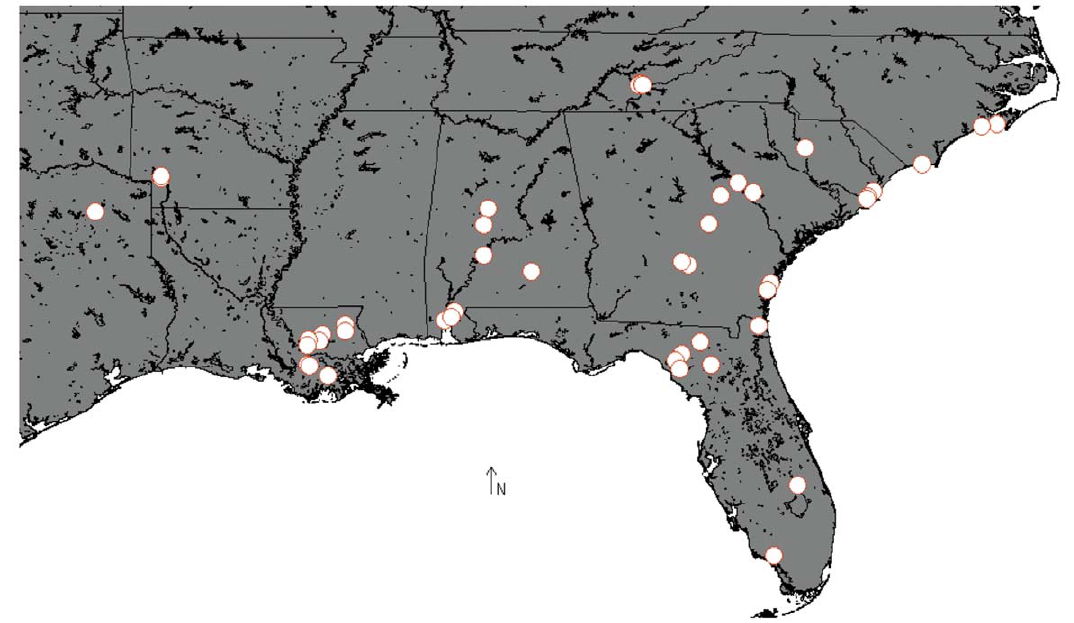
Figure 1. Sampling localities.